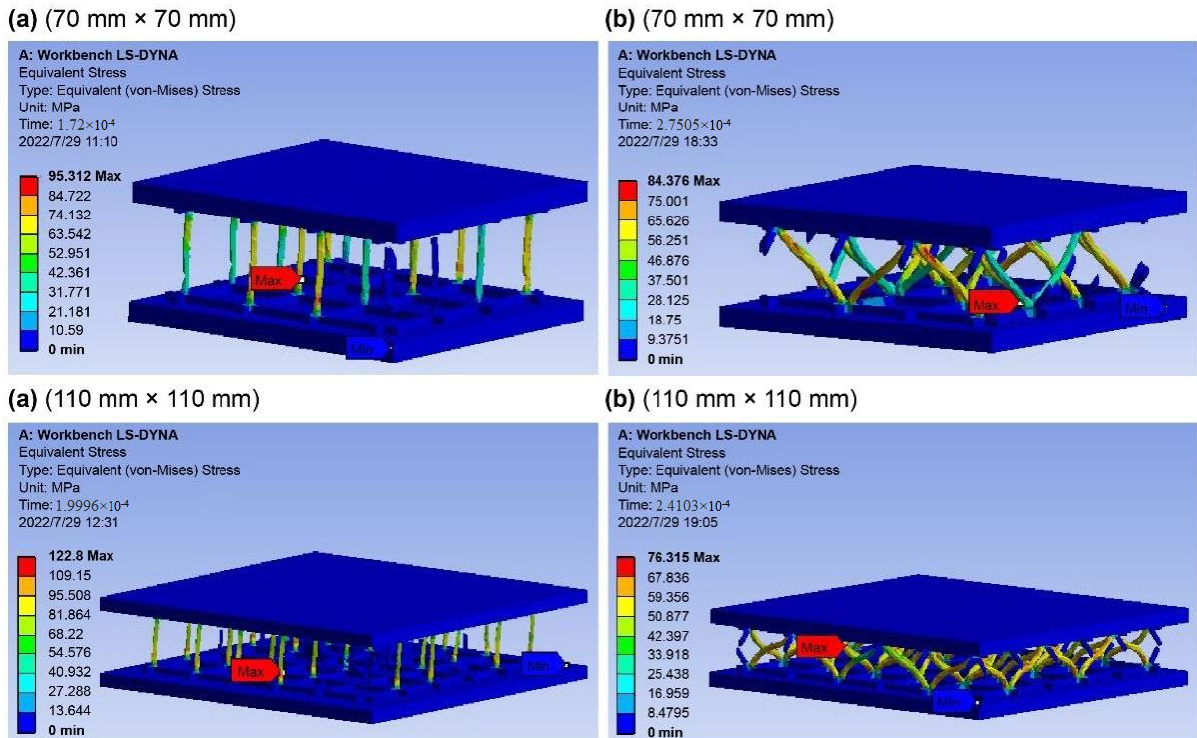
Figure 13. Bending simulation models. the double-sided, square shallow groove, and cylindrical deep holes ( a ) and optimized Warren truss with symmetrically inclined holes ( b ) resin stiffener structures.